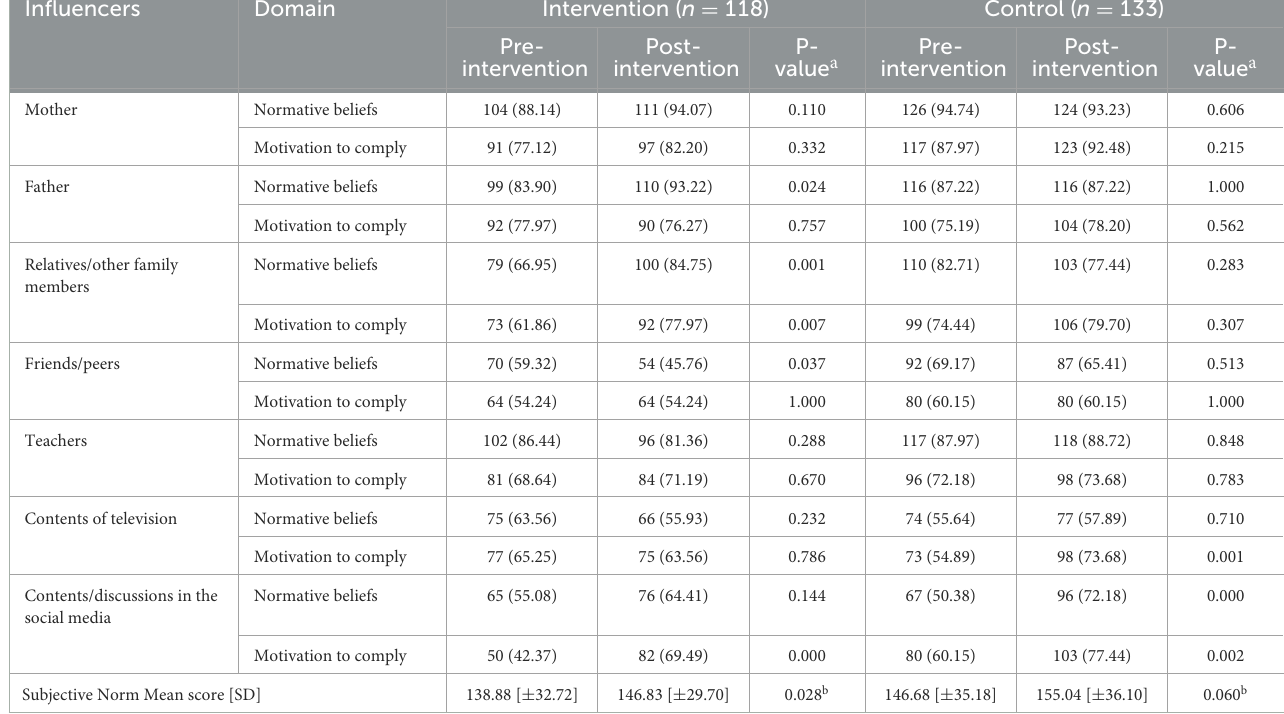
TABLE 4 Pre- and post-intervention comparison of subjective norms regarding consumption of healthy diet among intervention and control